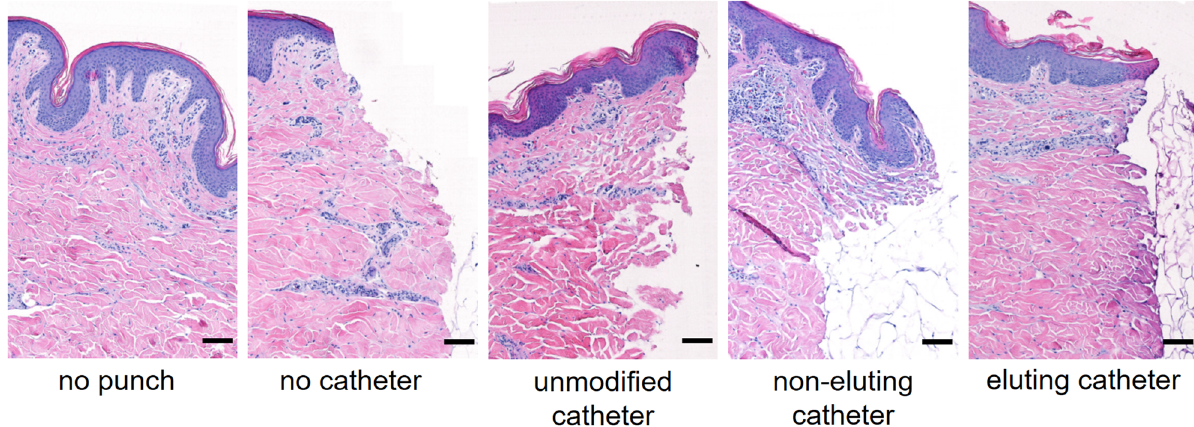
Figure 6. H&E stained tissue from 48 h ex vivo models visualized at 378×. In addition to conditions used above, a “no-punch” sample and “no-catheter” sample were used as reference controls. Images show a longitudinal cross-section with the skin surface on top and the skin-catheter interface on the right side of the image. Scale bar = 100